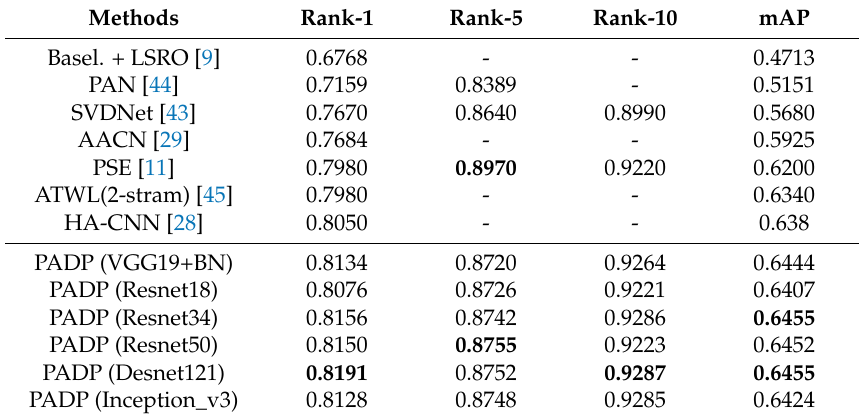
Table 5. Rank-1, rank-5, rank-10 and mAP of various methods on the DukeMTMC-ReID